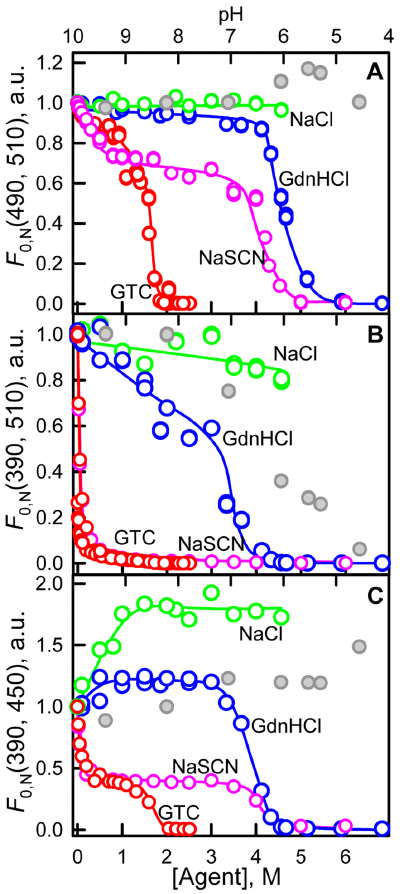
Figure 7. Ionic denaturants and salts effects on fluorescence of anionic and neutral chromophore of sfGFP. ( A ) Changes in the chromophore fluorescence intensity upon excitation of anionic chromophore at wavelength of 490 nm and detection at 510 nm. ( B ) Changes in the chromophore fluorescence intensity upon excitation of neutral chromophore at wavelength of 390 nm and detection at 510 nm. ( C ) Changes in direct fluorescence from neutral form at 450 nm at excitation wavelength of 390 nm. The value of fluorescence intensity corrected for the primary inner filter effect was normalized to equal chromophore concentration (see ‘‘Discussion’’ section). Agents used were GTC (red circles) and GdnHCl (blue circles), NaSCN (pink circles) and NaCl (green circles). Data on fluorescence intensity of sfGFP in different pH are shown in gray circles, axis of abscissas for these data is on